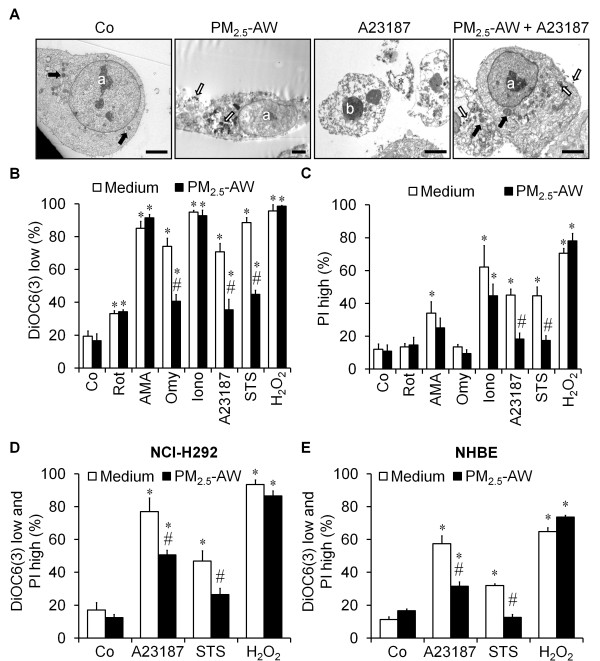
Parisian PM2.5 have an antiapoptotic effect against several death inducers. (A) Transmission electron microscopy of 16HBE cells treated 24 h with A23187 (3 μM) in the absence or in the presence of a 4 h pretreatment with 10 μg/cm2 PM2.5-AW. The micrographs illustrate that control or PM2.5-treated cells show normal nuclear chromatin condensation with the presence of some nucleoli (a) and normal ultrastructure of mitochondria (black arrow). PM's aggregates are localized near to the plasma membrane of cells exposed to particles or into the cytoplasm (white arrows). Treatment with A23187 alone triggered typical features of apoptotic cell death characterized by reduced cellular volume, massive chromatin condensation (b), formation of apoptotic bodies (black asterisk) and maintenance of the plasma membrane integrity. Note that PM2.5-AW pretreatment prevented A23187-induced morphological modifications and allowed 16HBE cells to retain nuclear or mitochondria morphologies similar to those of the control. Scale bar represent 5 μm. (B and C) After a 4 h pretreatment with PM2.5-AW (10 μg/cm2), 16HBE cells were exposed to different inducers of cell death for another 20 h such as mitochondrial respiratory chain inhibitors (rotenone (Rot, 5 μM), antimycin A (AMA, 25 μg/ml) and oligomycin (Omy, 5 μM)), calcium ionophores (ionomycin (Iono, 0.5 μM) and A23187, 3 μM), protein kinases inhibitor (staurosporine STS, 1 μM) and oxidative stress activator (H2O2, 500 μM). Then, cells were quantified for DiOC6(3) low or PI high staining by flow cytometry. (D and E) The human bronchial epithelial NCI-H292 cell line and NHBE primary cells were assessed by flow cytometry in the presence or the absence of PM2.5-AW pretreatement (10 μg/cm2) and apoptosis inducers: A23187 (3 μM), staurosporine (STS, 1 μM) and H2O2 (500 μM). Experiments were repeated three times, and means ± S.D. are shown. Significance was calculated with respect to untreated controls (*, p < 0.001) and with respect to non-pretreated cells with particles (#, p < 0.001).